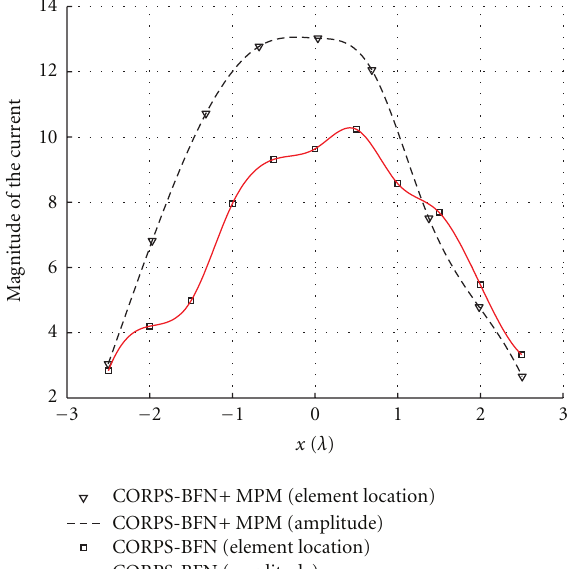
Figure 9: Amplitude distribution and antenna element location for the reference factor (CORPS-BFN) and the reconstructed factor (MPM + CORPS-BFN) for the beam no. 2 shown in Figure 5.